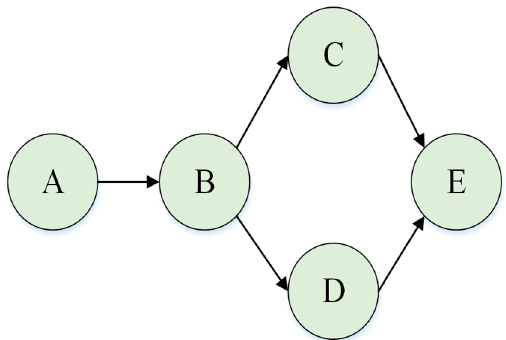
Figure 3. Sample of a Bayesian network.